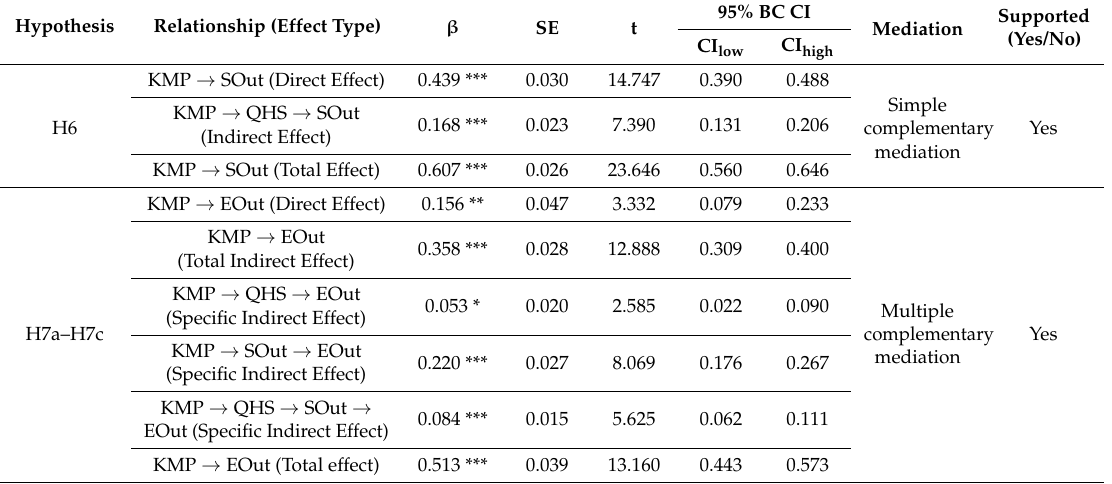
Table 6. Testing for direct